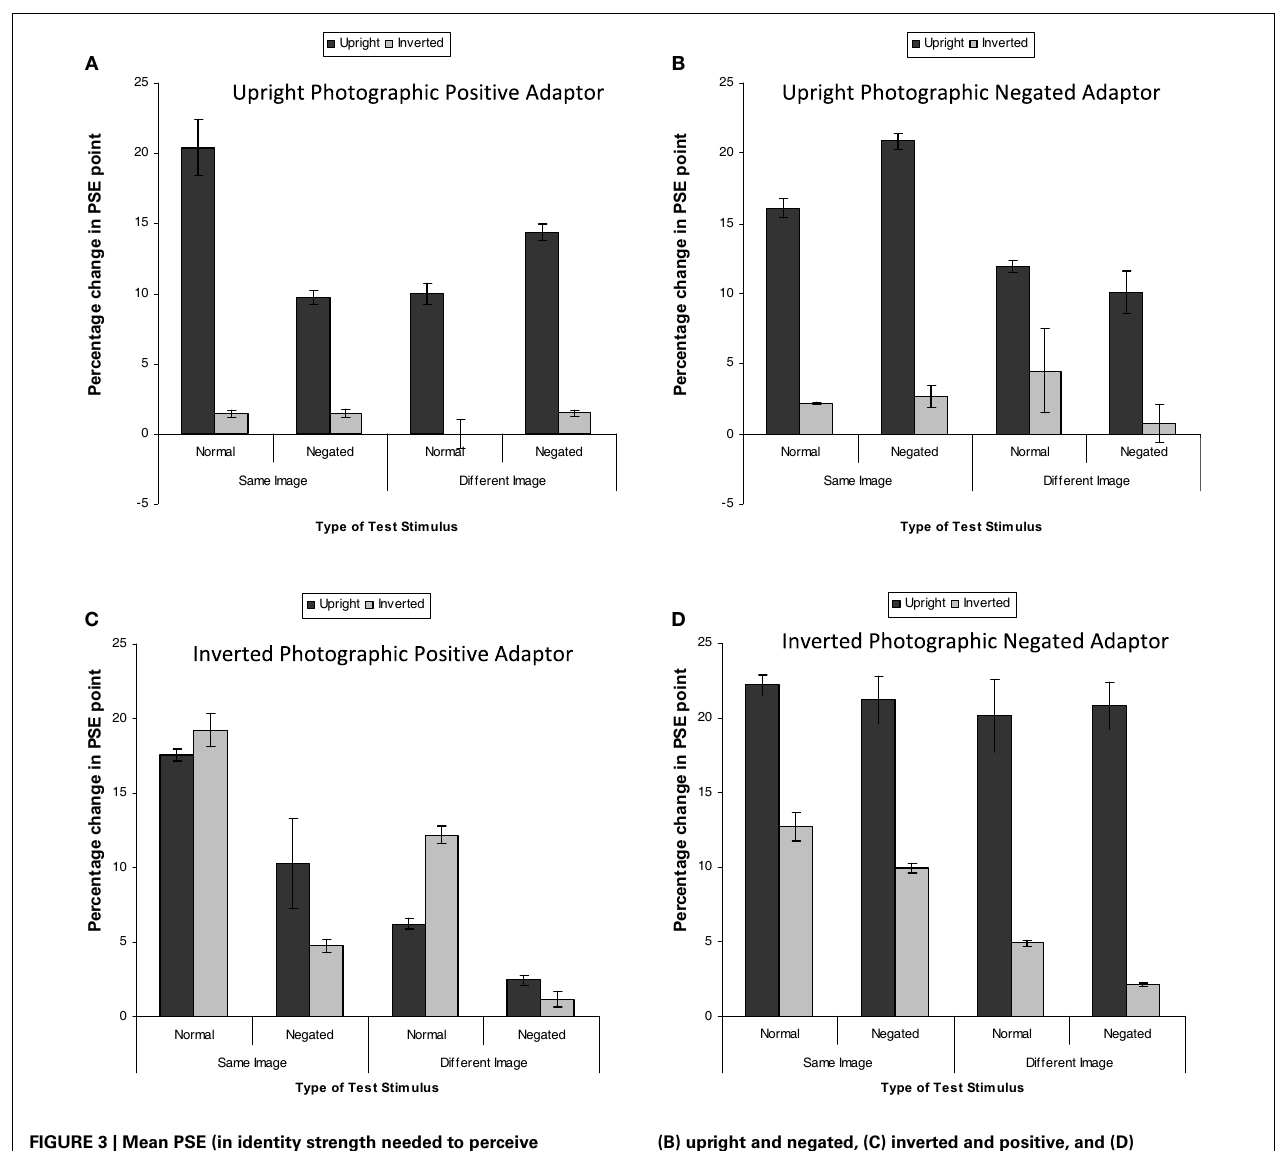
FIGURE 3 | Mean PSE (in identity strength needed to perceive the adapted identity) shift pre- to post-adaptation (as a measure of the magnitude of the aftereffect) for famous faces, when the adaptor is (A) upright and photographically positive,